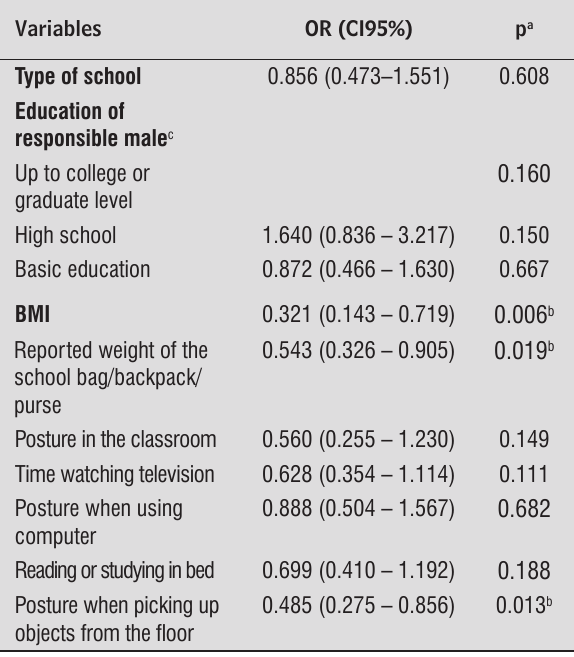
Table 3 - Multivariate analysis among the statistically signifi- cant variables in the bivariate analysis (p <